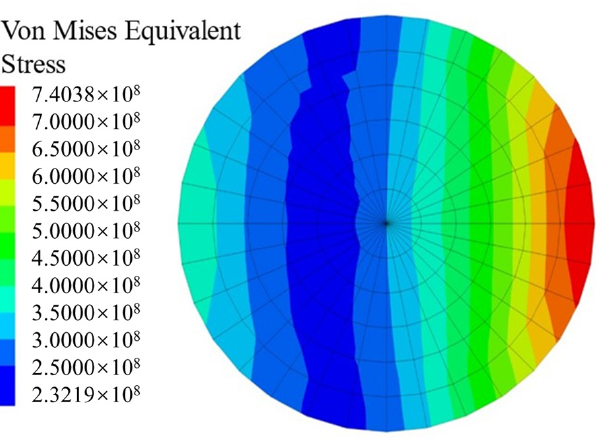
Figure 4. Von Mises equivalent stress of bolt section at bolt–structural surface intersection.